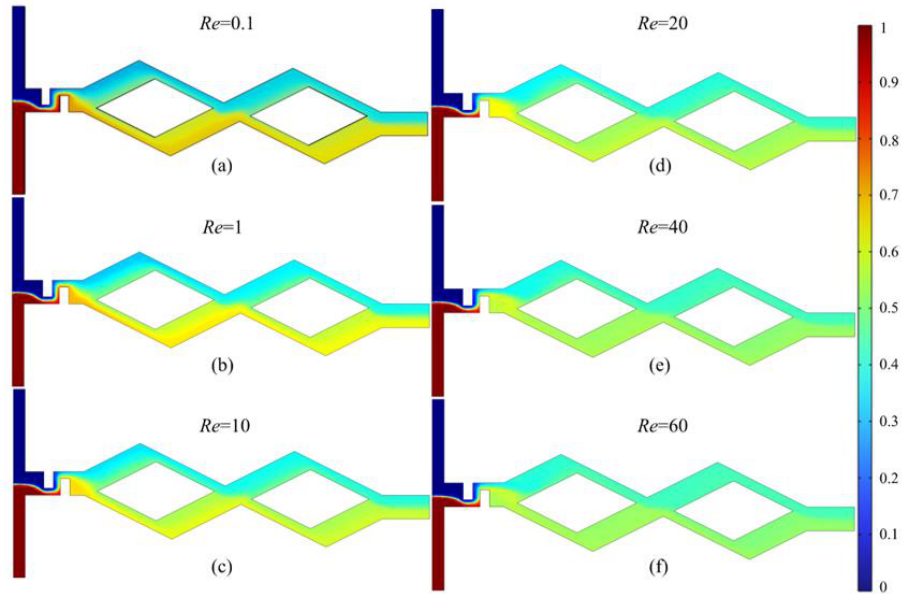
Figure 7. Concentration field distribution of asymmetric rhombus micromixer with baffles at Re = 0.1, 1, 10, 20, 40 and 60. ( a ) Re = 0.1; ( b ) Re = 1; ( c ) Re = 10; ( d ) Re = 20; ( e ) Re = 40; ( f ) Re = 60. Figure 8 indicates the velocity field distribution and concentration field distribution